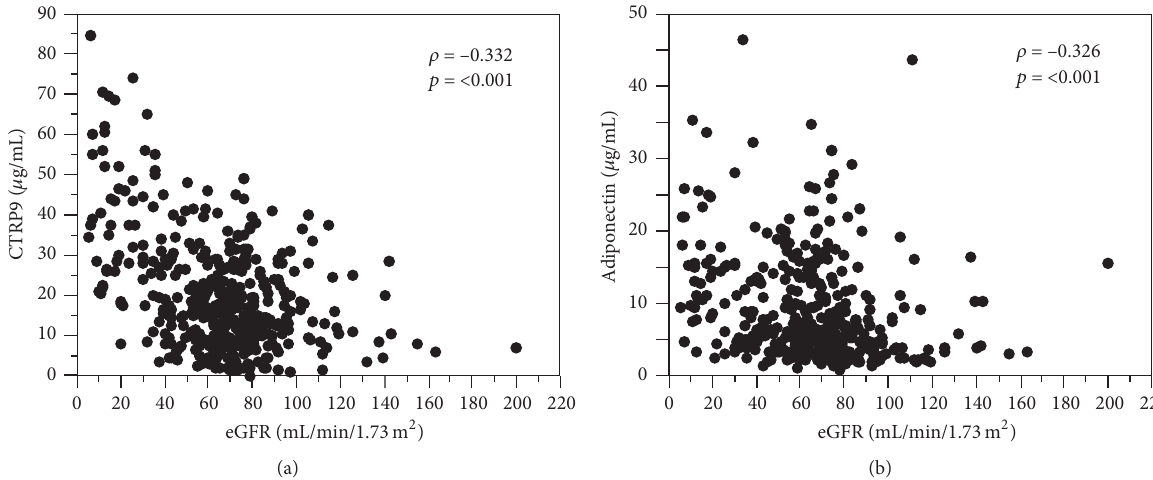
Figure 1: Association of estimated glomerular filtration rate (eGFR) with plasma C1q/tumor necrosis factor-related protein-9 (CTRP9) levels (a) or adiponectin levels (b) in subjects with type 2